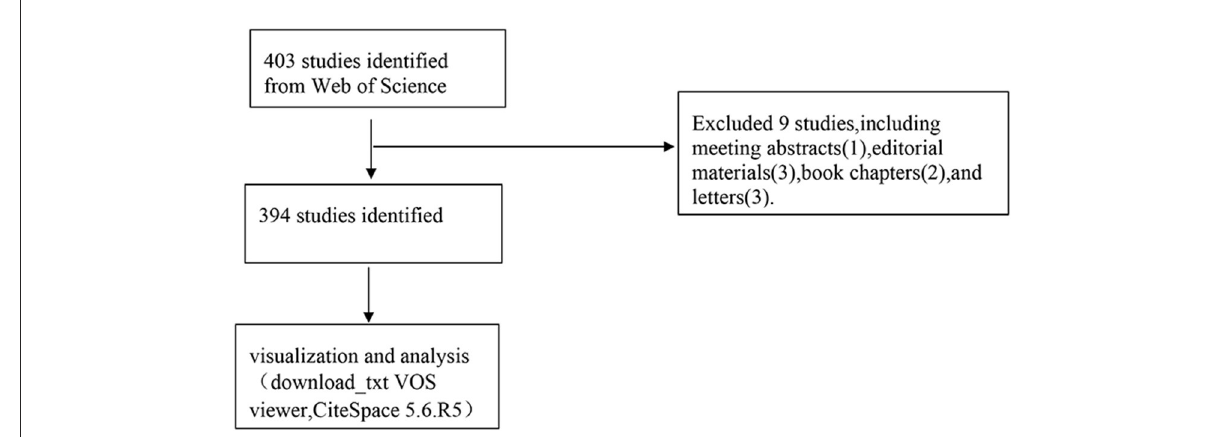
FIGURE1 Flowchart of literature screening.